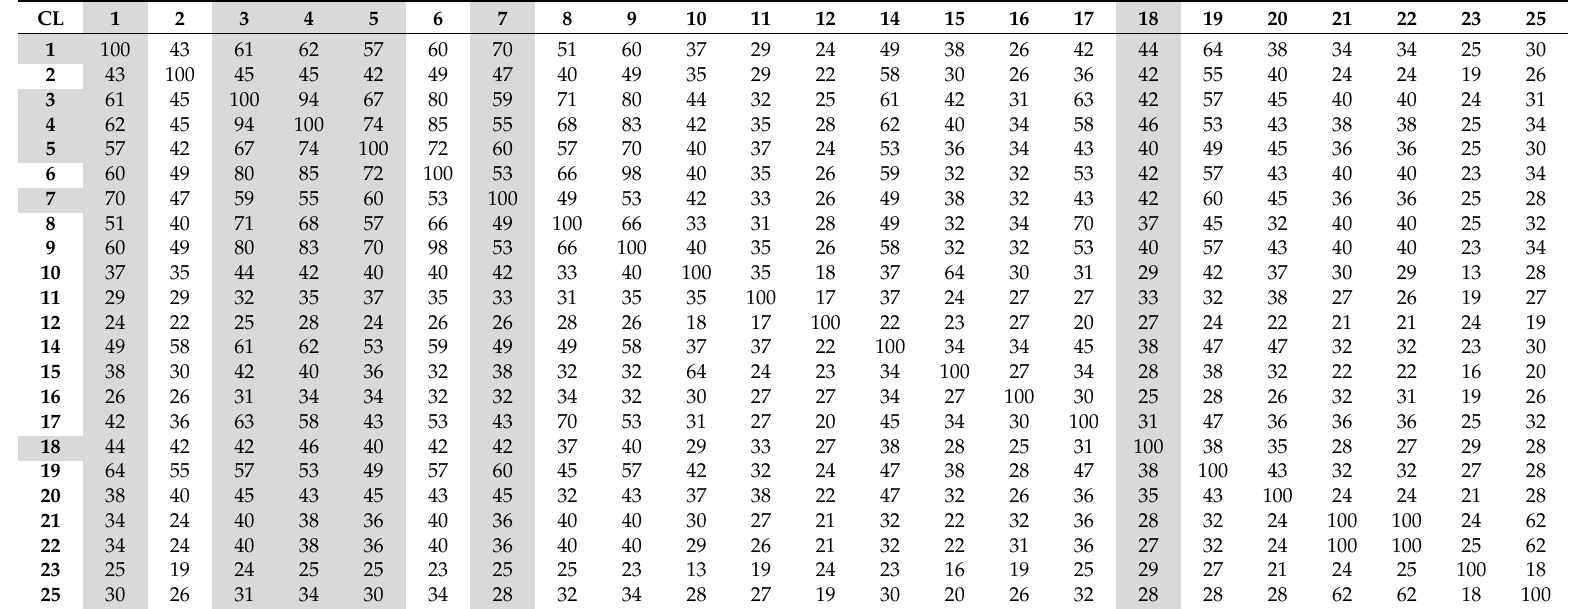
Table 4. Similarity matrix for first extracellular domains of human claudin (CL) family adhesion proteins created using Clustal Omega. Grey shading indicates claudins expressed in human bronchi and bronchioles. Note that: (i) some evidence indicates that claudin-7 may be an anion channel-forming rather than a sealing type claudin; (ii) the similarity data for claudin 10 are based on the canonical claudin 10b sequence; (iii) the data for claudin 18 are based on the canonical sequence of the A1 isoform (UniProt: